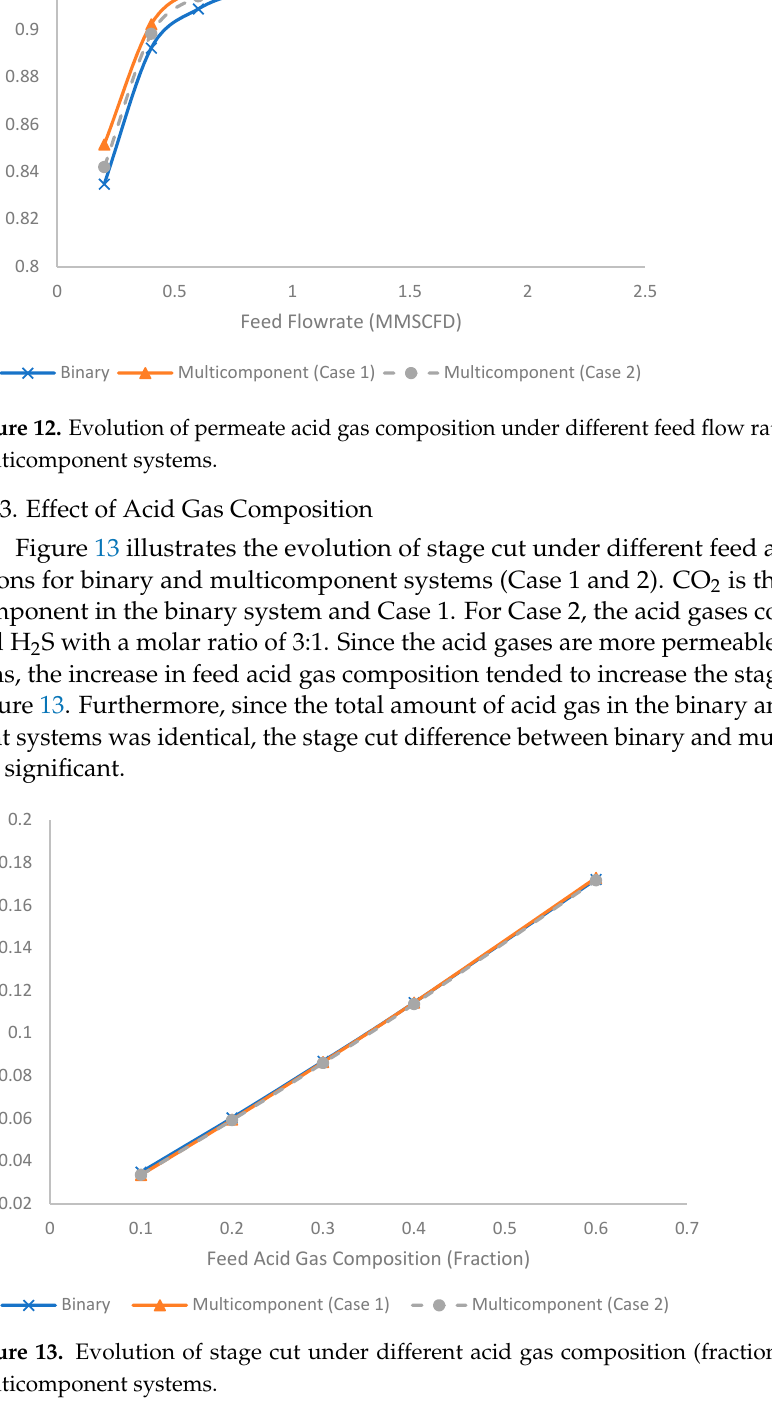
16 of 22 Figure 11. Evolution of product purity (%) under different feed flow rates for binary and multicom- ponent systems. Figure 12 shows the permeate acid gas composition under different feed flow rates